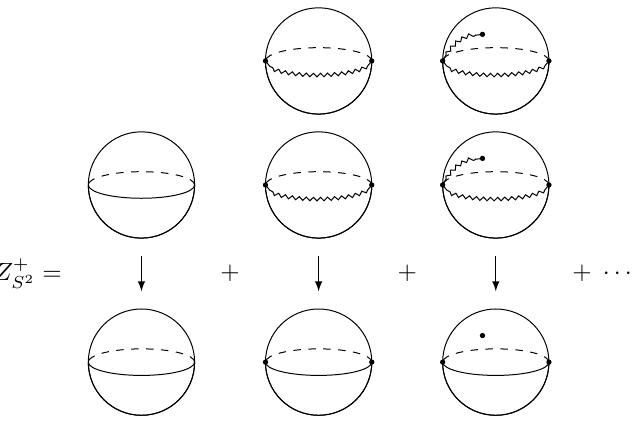
Figure 5 . Z + can be expressed as a sum over worldsheets with holes corresponding to closed S 2 strings that wind around the (cid:10)-points on S 2